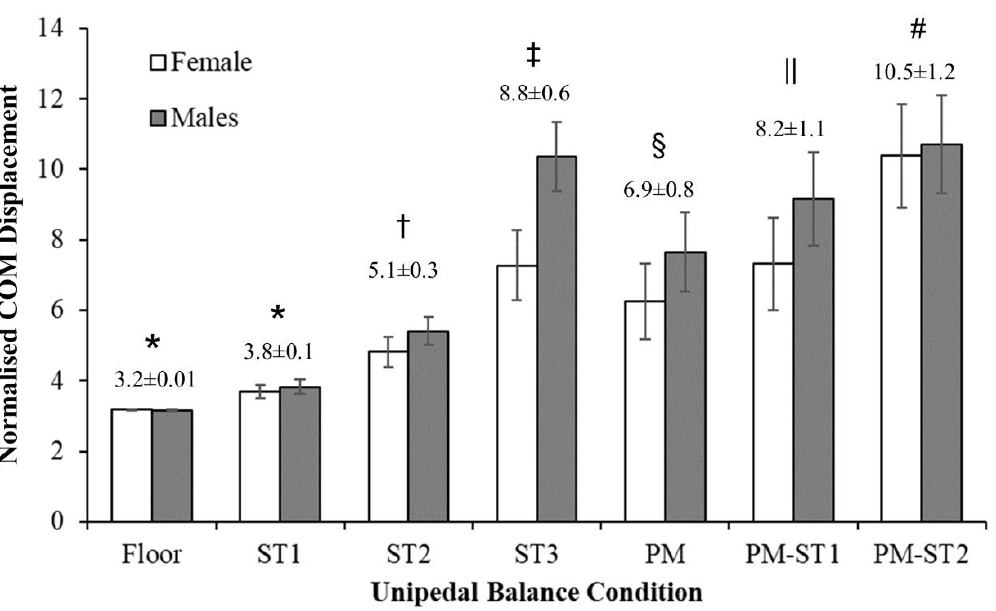
Figure 3. Mean normalized center of mass (COM) displacement for all balance conditions in females and males. Error bars represent standard error. Note that there were no significant di ff erences between males and females. Mean ( ± standard error) normalized COM displacement values are shown for each balance condition. * Balance condition significantly di ff erent from all other conditions ( p < 0.05). † Balance condition significantly di ff erent from all other conditions except PM and PM-ST1 ( p < 0.05). ‡ Balance condition significantly di ff erent from all other conditions except PM, PM-ST1 and PM-ST2 ( p < 0.05). § Balance condition significantly di ff erent from all other conditions except PM-ST1 ( p < 0.05). || Balance condition significantly di ff erent from all other conditions except ST2, ST3 and PM-ST2 ( p < 0.05). # Balance condition significantly di ff erent from all other conditions except ST3 and PM-ST1 ( p < 0.05). Table 2. P-values and effect sizes ( dz ) for post hoc comparisons between balance conditions.